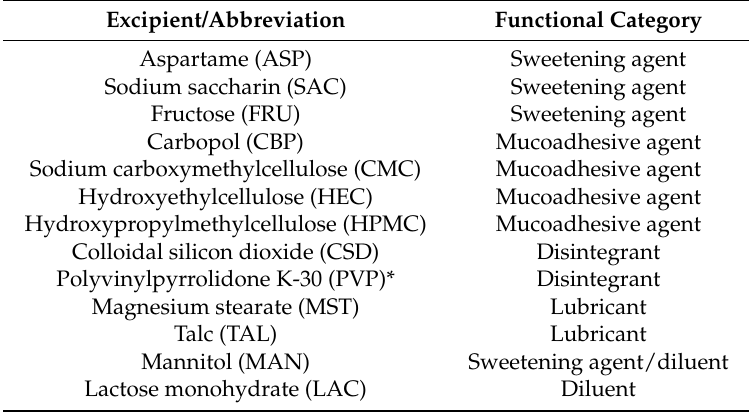
Table A1. Functional categories of the pharmaceutical excipients used in the compatibility study.